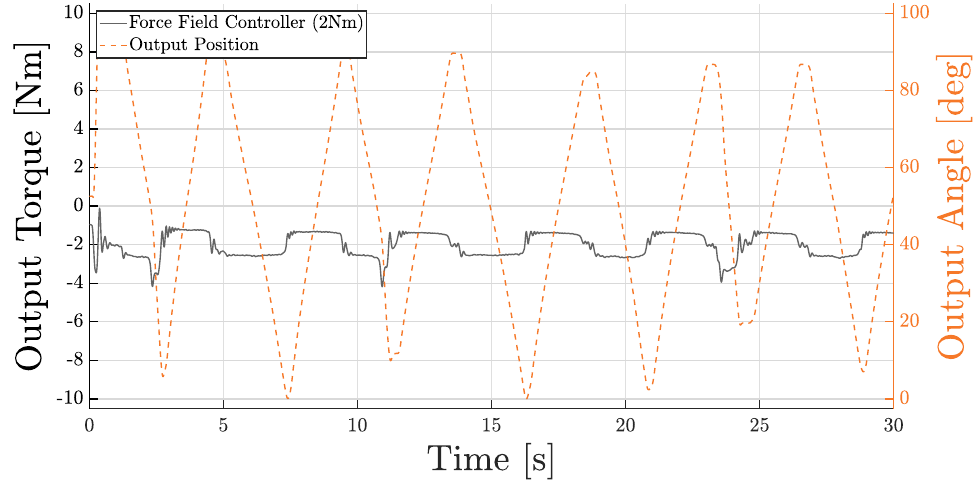
Figure 18. Force-field controller realised with the SMARCOS. This corresponds to a variant of the zero-torque controller shown in Figure 17, where an offset is applied. The output torque oscillates around the targeted value of − 2